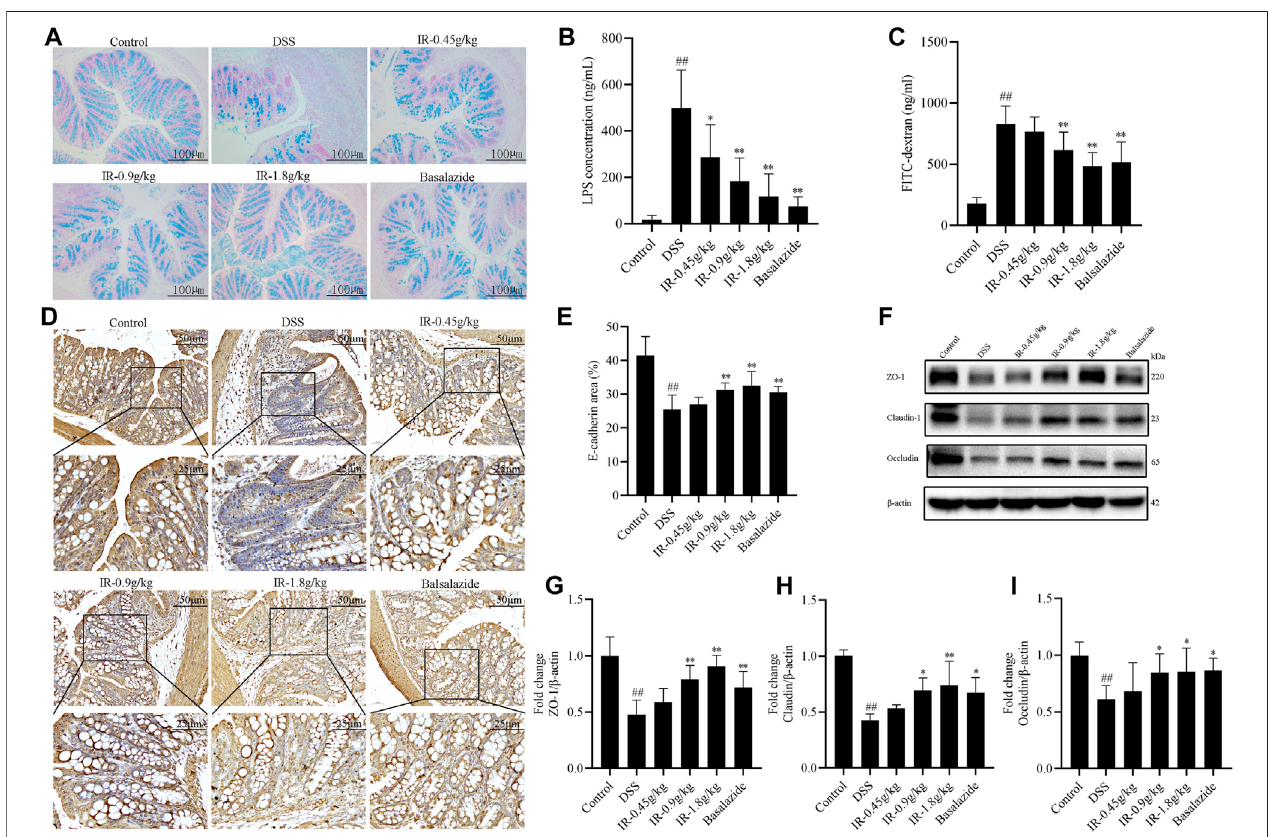
FIGURE 5 | IRalleviatesintestinalmucosal barrierdamageinUC mice. (A) Detection ofacidic mucuslayerincolon ofmice byalcianbluestaining ( n = 6). (B) The LPS contentinserumofmice( n =6). (C) TheFITC-dextrancontentinserumofmice( n =6). (D) ImmunohistochemicaldetectionofE-cadherinproteinexpressionincolonofmice ( n =3). (E) HistochemicalpositiveareastatisticsofE-cadherin( n =3). (F) Theprotein levelsofZO-1,claudin-1,and occludin incolon detected bywestern blotting. (G – I) The grayintensityanalysisofZO-1,claudin-1,andoccludinproteins,respectively( n =3).Alldatawerecomparedusingone-wayANOVA,and p -valuesre fl ecteddifferences between experimental